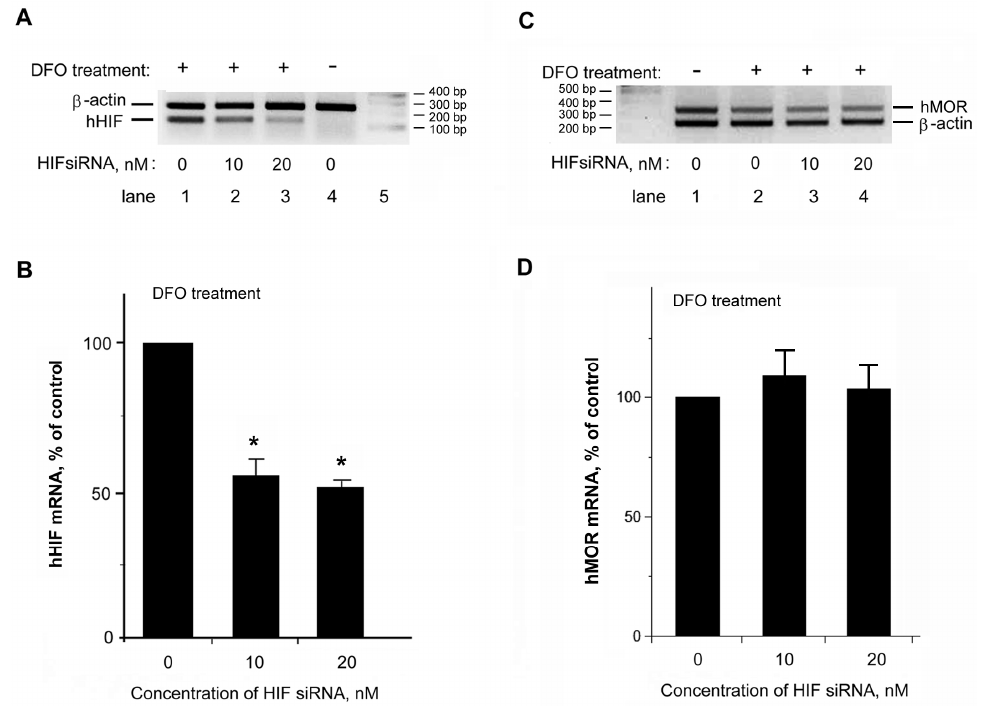
Figure 5. Examined effects of hHIF-1 α siRNA on the levels of hHIF-1 α and hMOR mRNAs. ( A ) NMB cells were transfected with hHIF-1 α siRNA (lane 2, 10 nM; lane 3, 20 nM) or without hHIF-1 α siRNA (indicated as 0 nM; lanes 1 and 4). Twenty-four hours after transfection, cells were treated without (lane 4, − ) or with DFO for 24 h (lanes 1–3, +). RNAs were extracted from transfected cells. Semi-quantitative RT-PCR was carried out by using a pair of human hHIF-1 α (hHIF) primers. The β -actin primers, as the internal standard, were also added to PCR reaction for normalization use. PCR products were separated by gel electrophoresis. Lane 5: DNA markers; ( B ) quantitation of human hHIF-1 α mRNA levels is shown, with the normalized hHIF-1 α mRNA level from the DFO treated sample without siRNA as 100%. The hHIF-1 α siRNA significantly knocked down the endogenous hHIF-1 α mRNA. Histograms represent mean ± S.E.M. Experiments were repeated eight times. Asterisk “*” indicates p < 0.01 ( t -test); ( C ) NMB cells were transfected with hHIF-1 α siRNA (lane 3, 10 nM; lane 4, 20 nM) or without hHIF-1 α siRNA (0 nM in lanes 1 and 2). Twenty-four hours after transfection, cells were treated without (lane 1, − ) or with DFO for 24 h (lanes 2–4, +). Semi-quantitative RT-PCR was carried out by using a pair of hMOR primers, along with a pair of β -actin primers as the internal standard for normalization use. PCR products were separated by gel electrophoresis. Lane 1: DNA markers; ( D ) quantitation of hMOR mRNA levels is shown, with the normalized hMOR mRNA level from the DFO treated sample without siRNA as 100%. The hHIF-1 α siRNA treatment did not alter the endogenous level of hMOR mRNA. Histograms represent mean ± S.E.M. Experiments were repeated eight times.